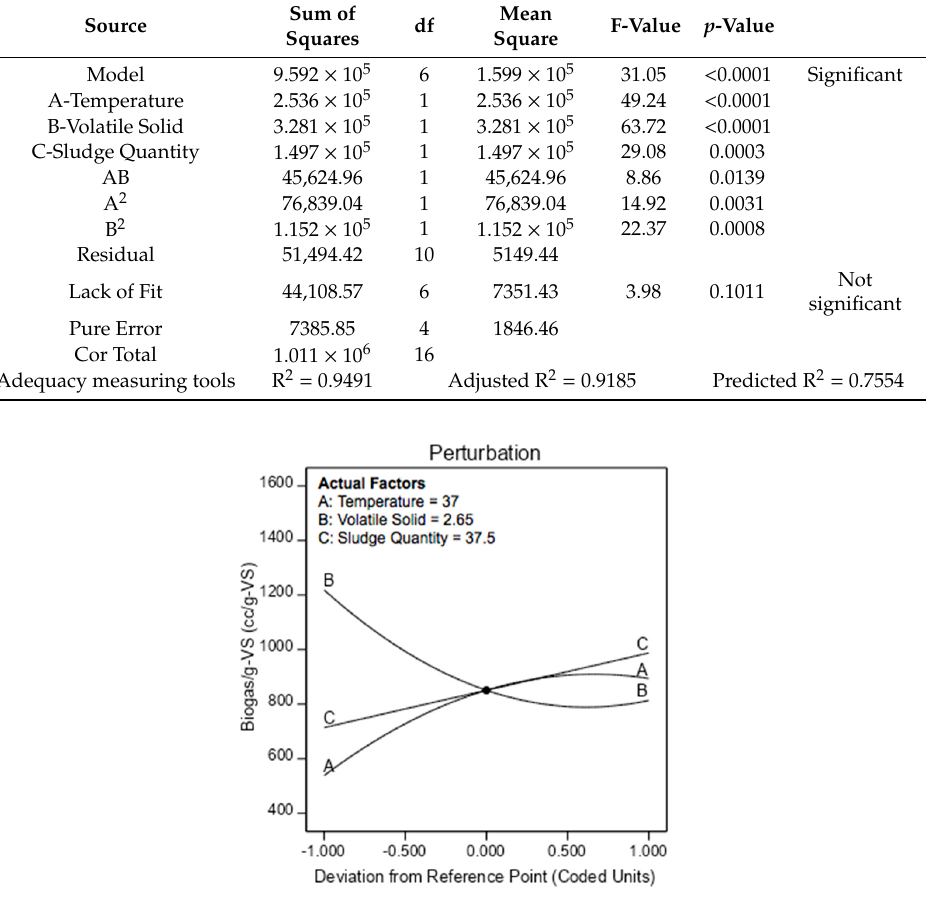
Table 6. ANOVA table for biogas g − 1 -VS response.